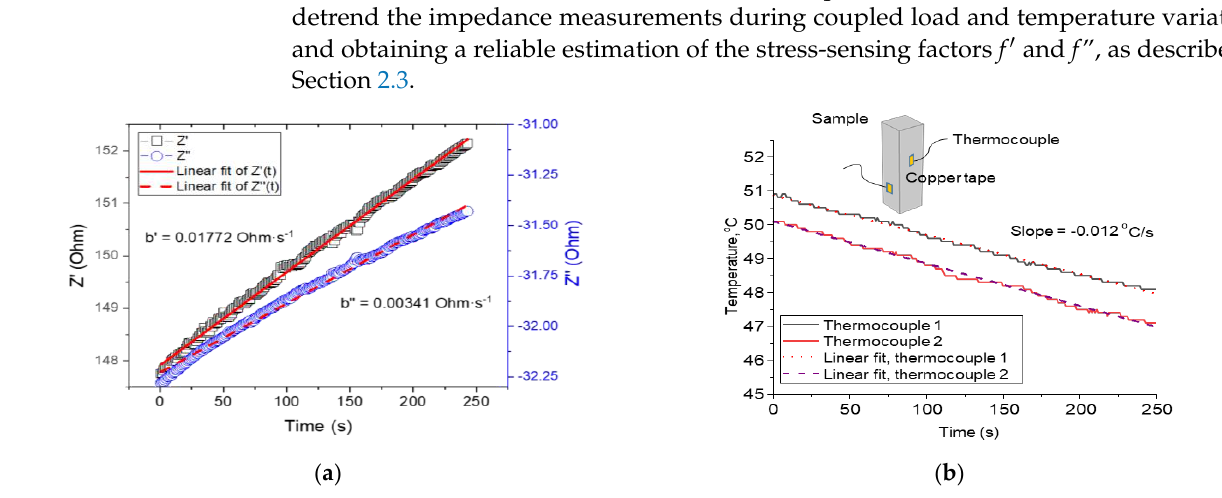
( b ) Figure 7. ( a ) Relative variation of the resistance (real part, Z ′ ) and ( b ) relative variation of the reac- tance (imaginary part, Z ″ ) with compressive loading for representative mortars at room tempera-